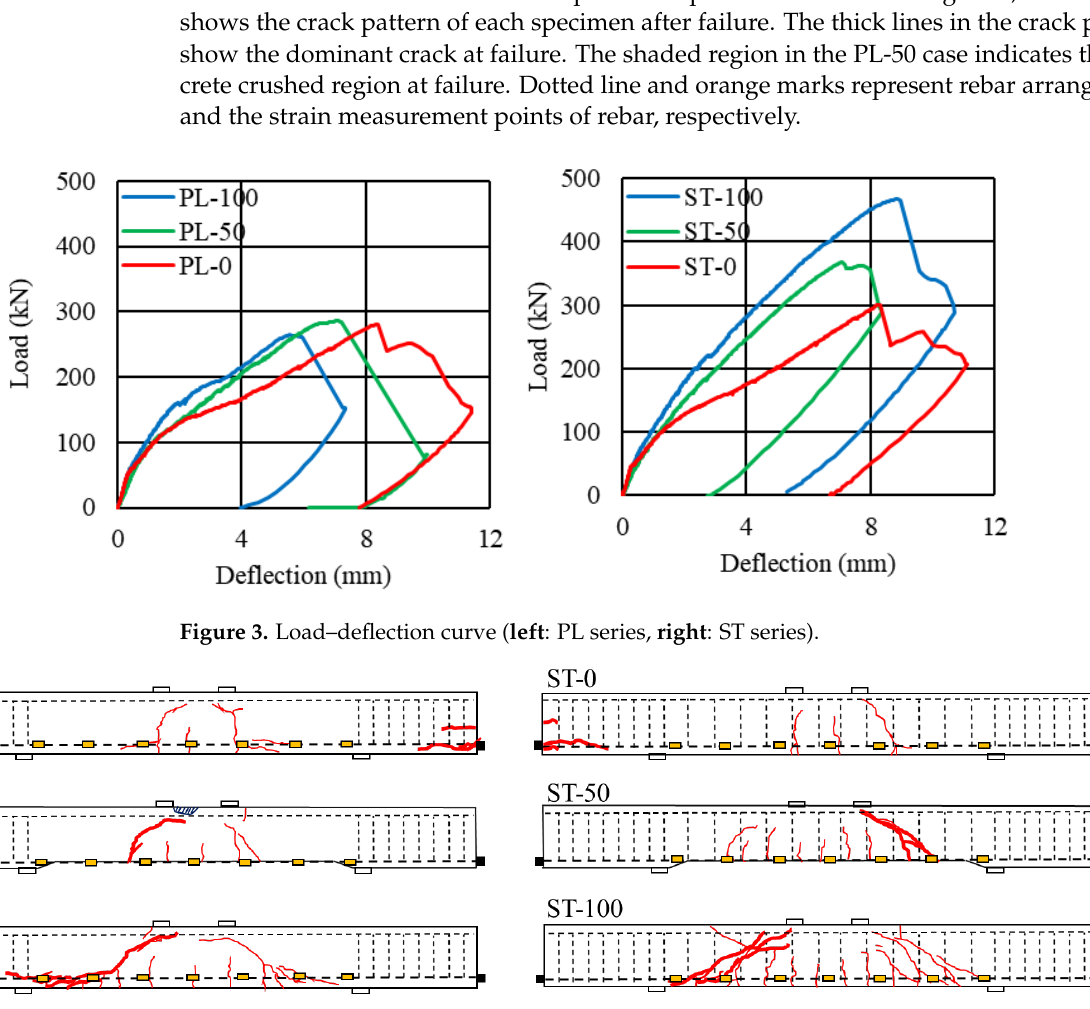
Figure 4. Crack pattern (thick line: dominant cracks at failure, shaded area: concrete spoiled area at failure).